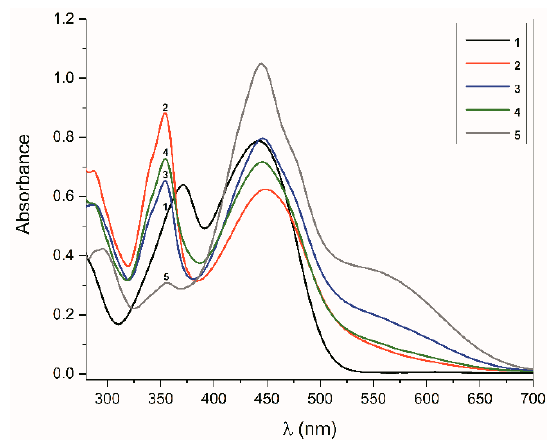
Figure 7. Change of UV-Vis spectrum of compound 2 (5 × 10 − 5 mol·dm − 3 ), in the presence of TBAF (1 × 10 − 3 mol·dm − 3 ), and during irradiation in DMF: 1) hydrazone 2 ; 2) hydrazone 2 + TBAF; 3) mixture 2) after 3 h in the dark, 25 °C; 4) mixture 3) after irradiation with 430 nm light; 5) mixture 4) after 24 h in the dark 25 °C.